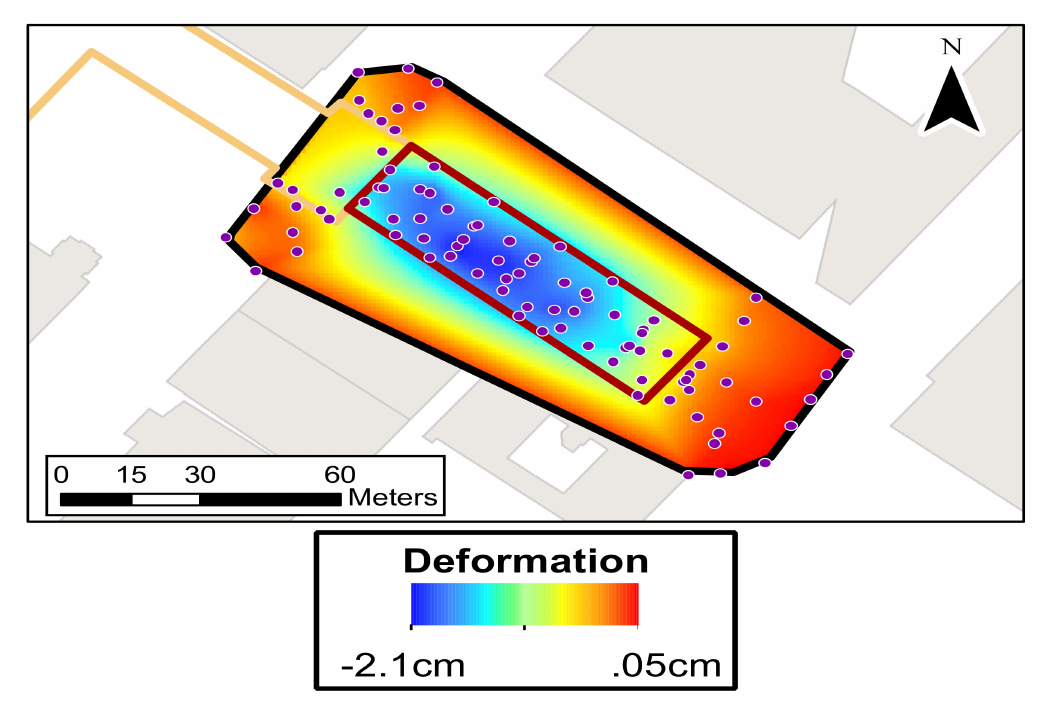
Figure 2. GSSP measurement locations and the interpolated surface of vertical displacements measured between 25 June 2018 and 25 February 2019.